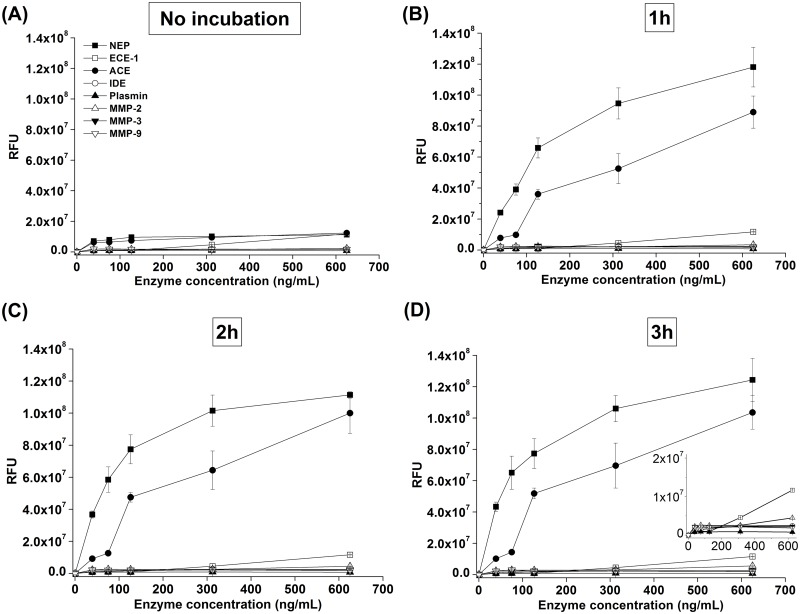
The specificity of qf-Aβ(12–18)C for various enzymes.qf-Aβ(12–18)C (2 μM) was reacted with different concentrations of the indicated enzymes without or with incubation at 37°C for 1, 2, and 3 hr. Inset in (D): the extension of the y-axis. The fluorescence intensity was measured at 360Ex/465Em.